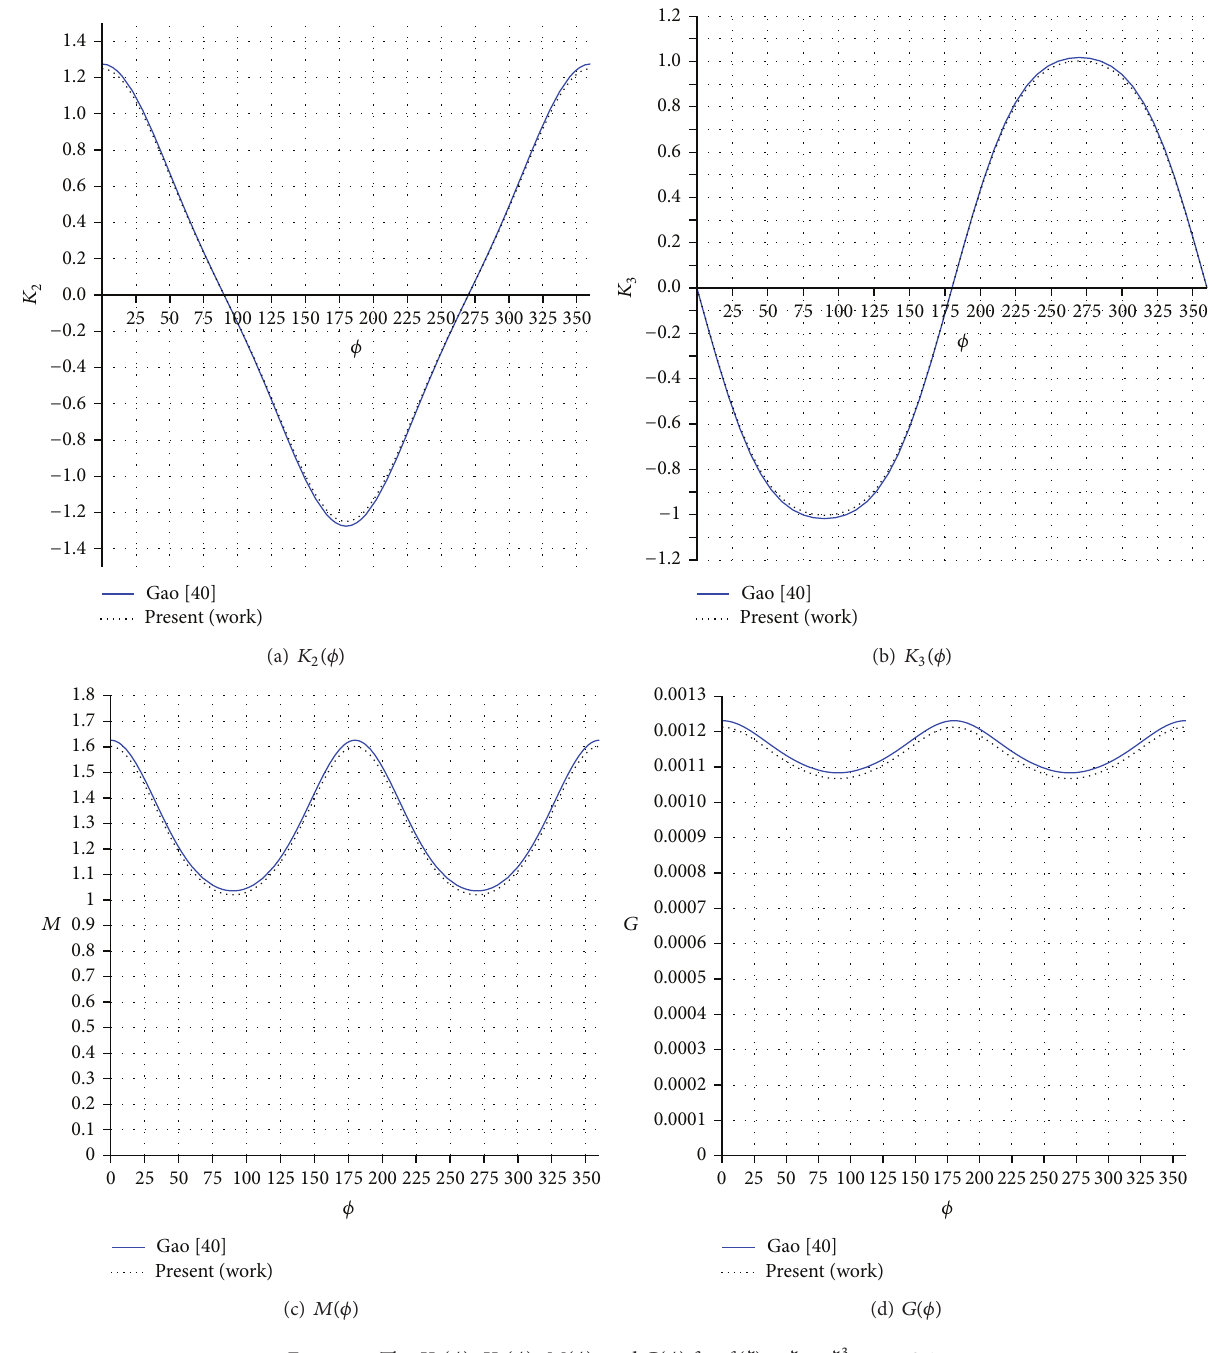
Figure 7: The 𝐾 2 (𝜙) , 𝐾 3 (𝜙) , 𝑀(𝜙) , and 𝐺(𝜙) for 𝑓(𝜁) = 𝜁 + 𝑐𝜁 3 at 𝑐 = 0.1